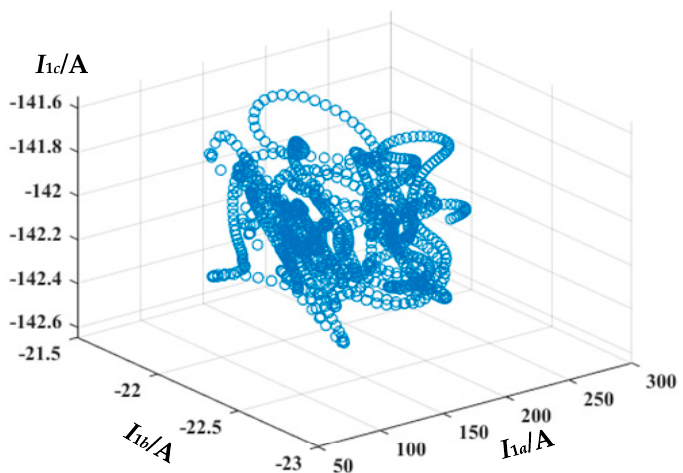
Figure 8. The 3D map of the sheath current matrix U .